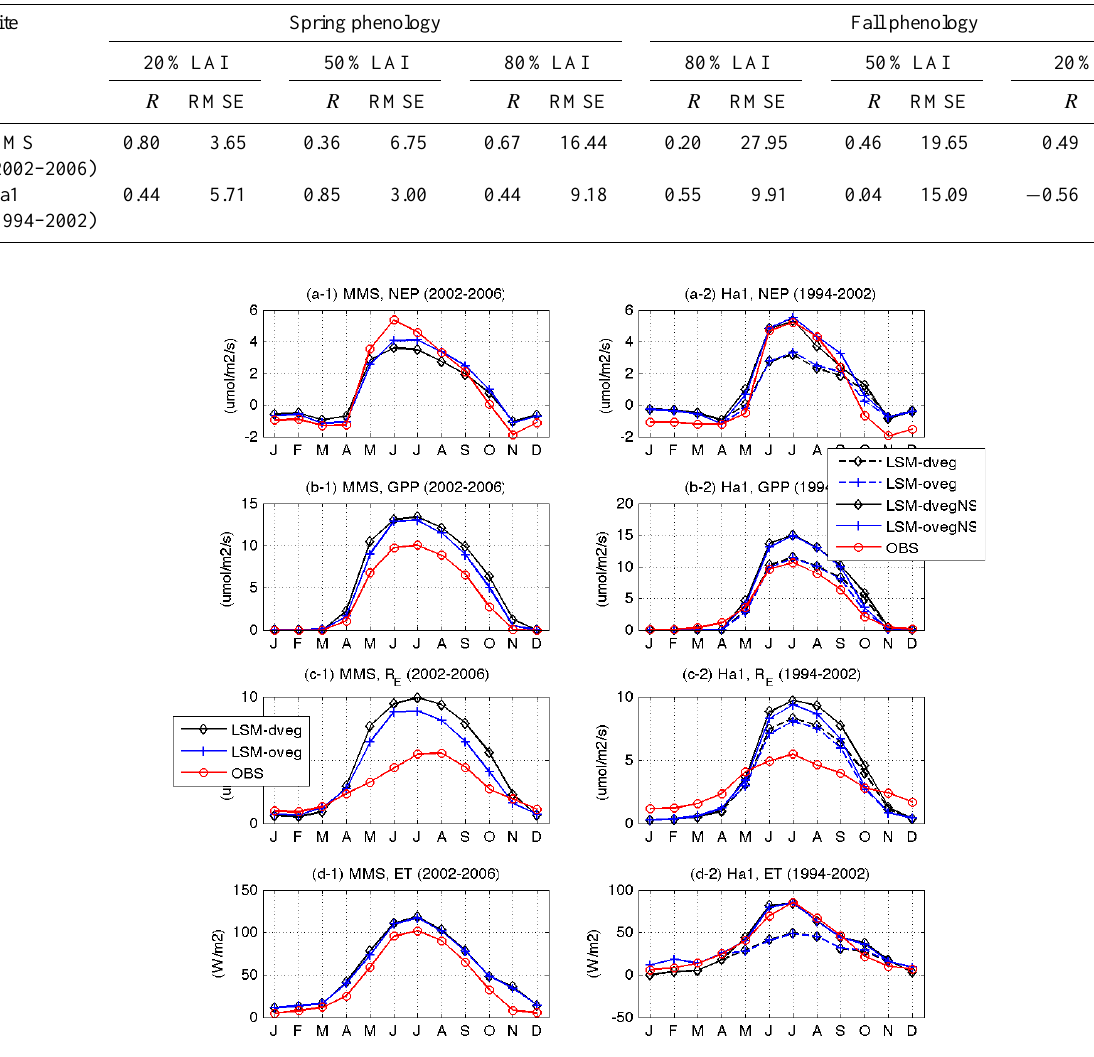
Figure 4. Average monthly fluxes in MMS for 2002–2006 and in Ha1 for 1994–2002: (a) NEP, (b) GPP, (c) R E and (d)